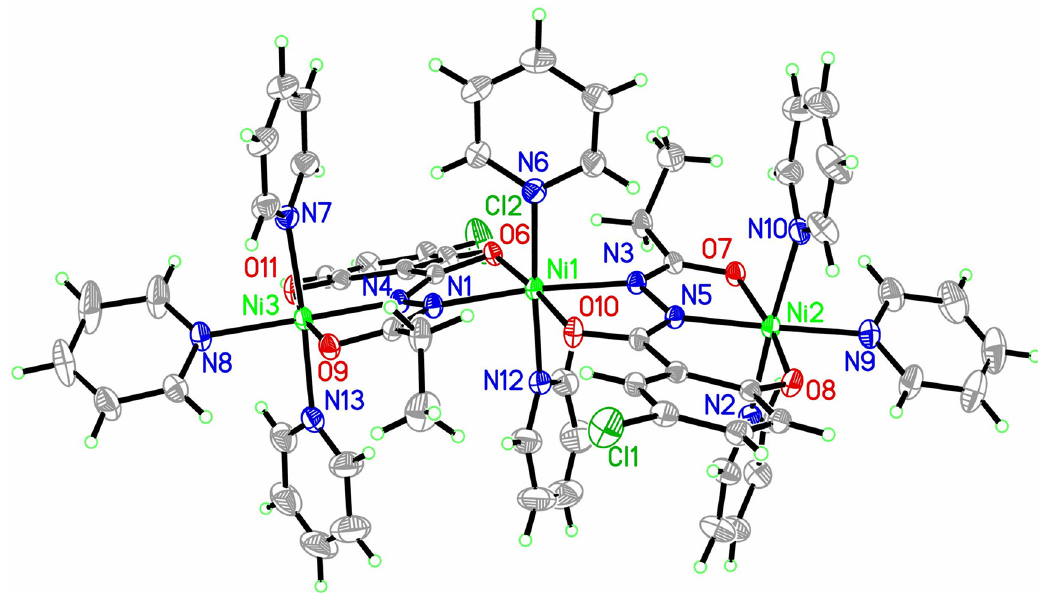
Figure 1: The crystral structure of complex 1.